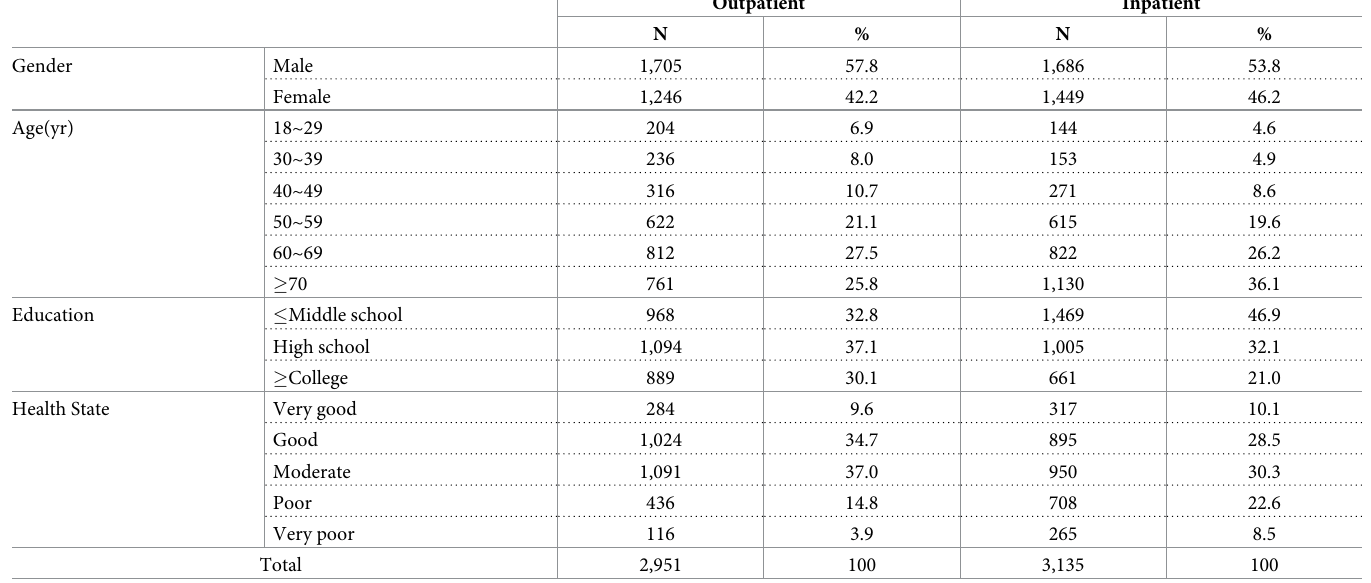
Table 1. General characteristics of